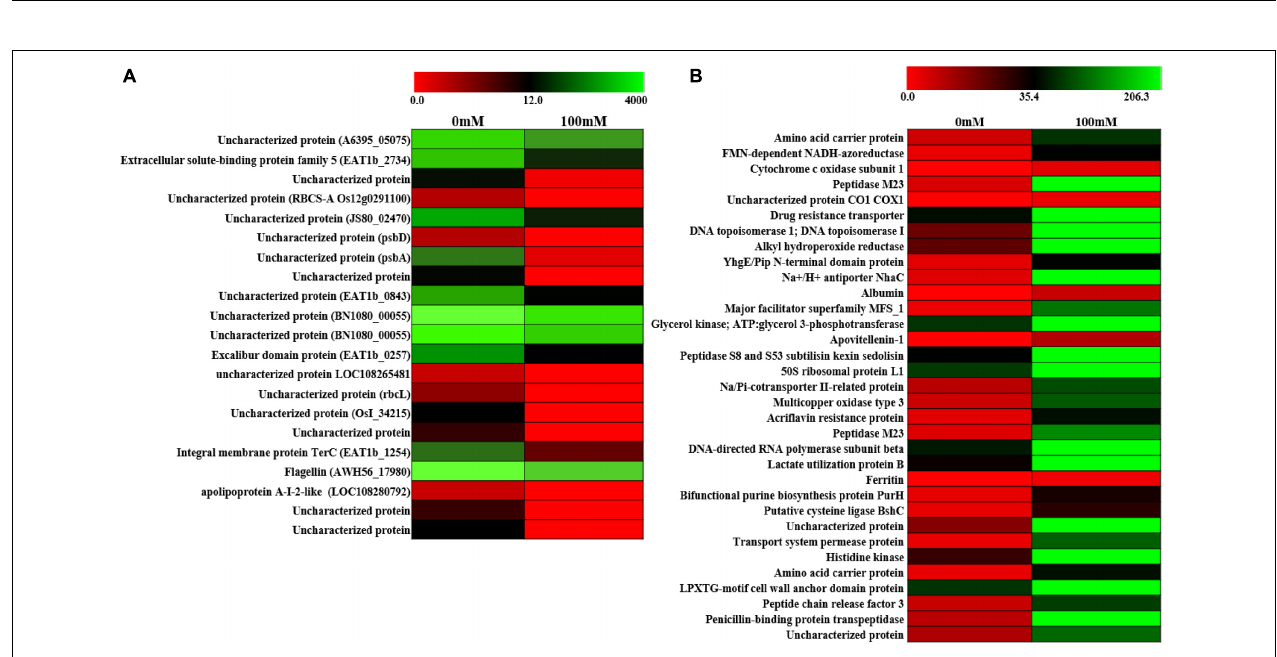
FIGURE 4 | Differential expression of gene (DEG) analysis of PHM11. (A) Heatmap of the downregulated genes and (B) heatmap of the upregulated genes. Red color indicates no expression while green indicates highest expression.